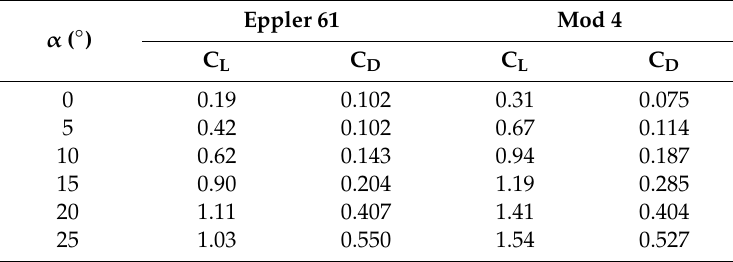
Table 2. Lift and drag coefficient for the original and modified airfoil at different angle of attack.